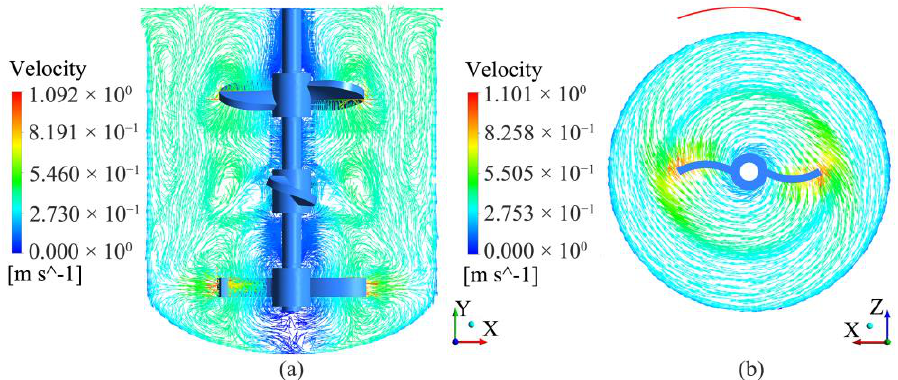
Figure 7. Velocity vector diagram when the medium is water and Re = 44,910. ( a ) TBC-A type agitator, Plane 1:XY,Z = 0 mm; ( b ) TBC-A type agitator, Plane 3:XZ,Y = 70 mm.